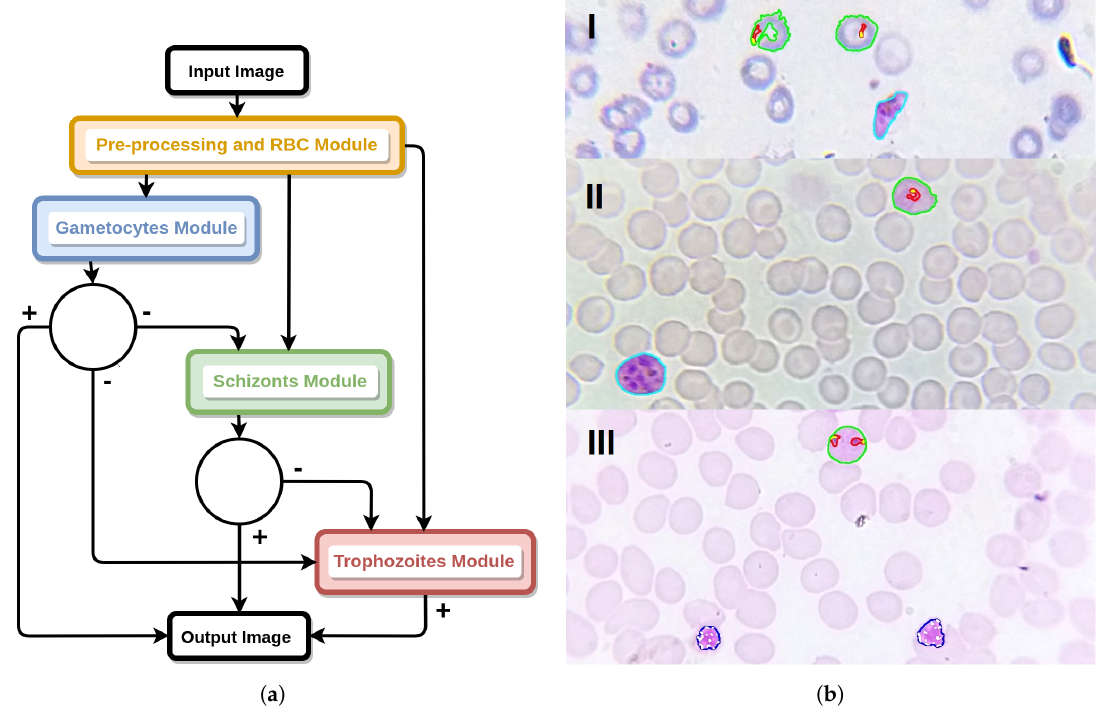
Figure 14. Classification models workflow. ( a ) Diagram of the classifier models workflow for the detection of multiple species-stage combinations in a single image. ( b ) Illustrative examples with detection of: (I) P. falciparum trophozoites and gametocyte; (II) P. ovale trophozoite and gametocyte; (III) P. malariae trophozoites and